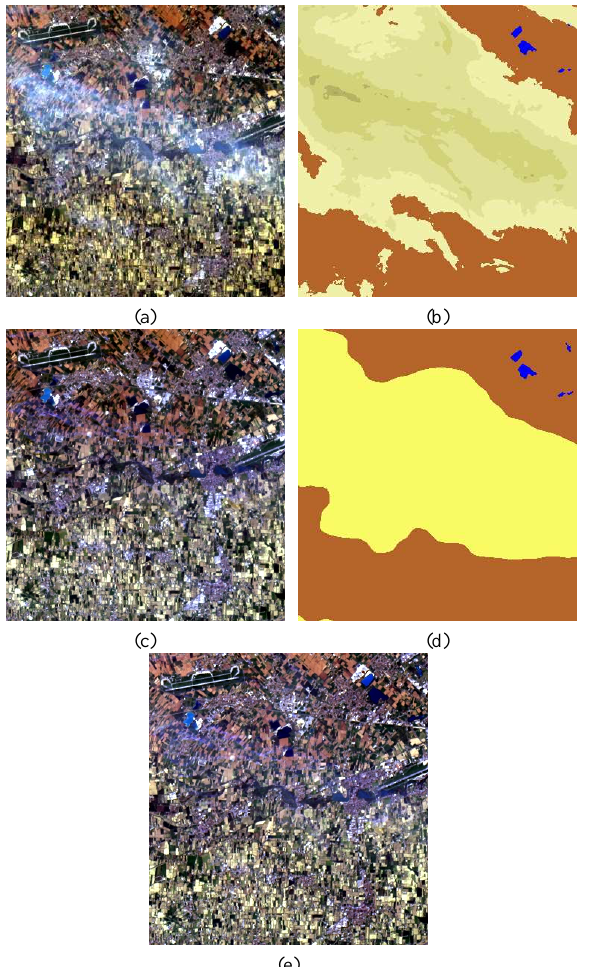
Figure 1: Cirrus removal in the Landsat-8 data (subscene): a) the original (RGB composite), b) the 1.38 µ m based decirrus map, c) the 1.38 µ m based decirrus, d) the CTM cirrus map, e) the CTM decirrus.